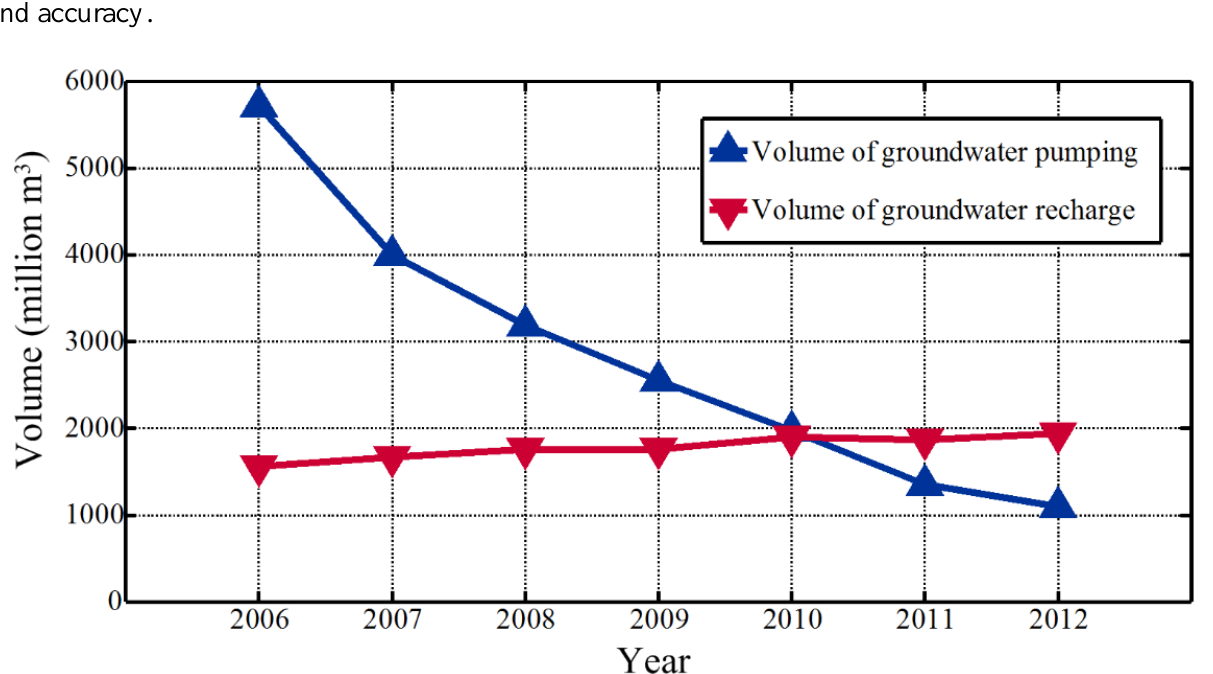
Figure 8. The groundwater pumping and recharge volume fulfilled in Shanghai for every year in the period of 2006–2012. The data are obtained from the Shanghai Water Resource Bulletin